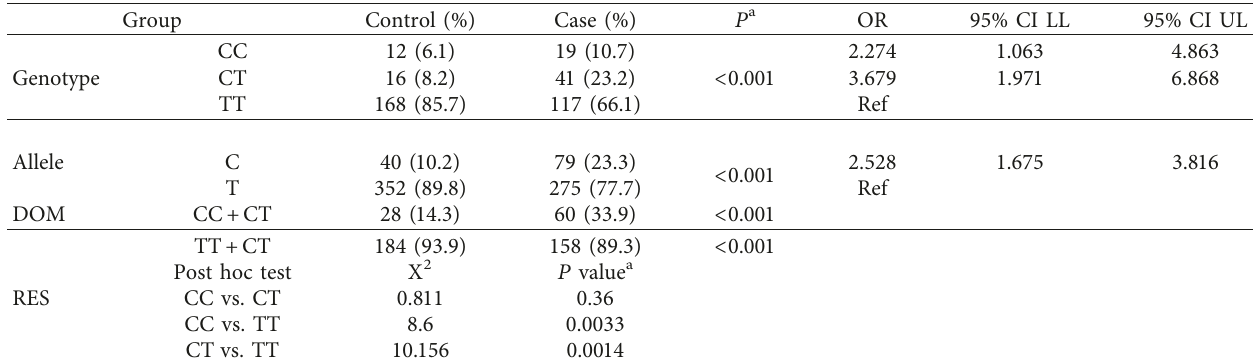
Table 3: Genotype and allele frequencies of ECE rs212526 polymorphism.